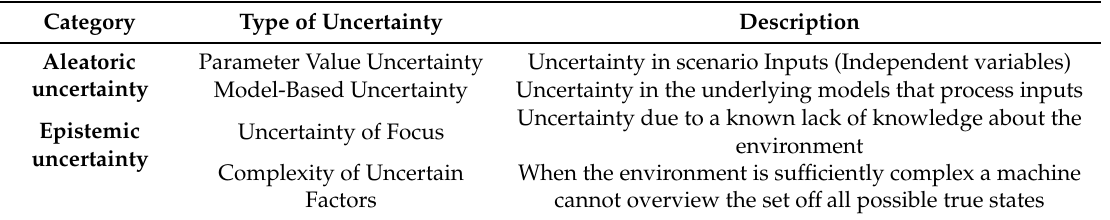
Figure 1. Conceptual Adaptive Human Machine Decision Space. Table 2. The categorisations of collective uncertainty for autonomous systems.